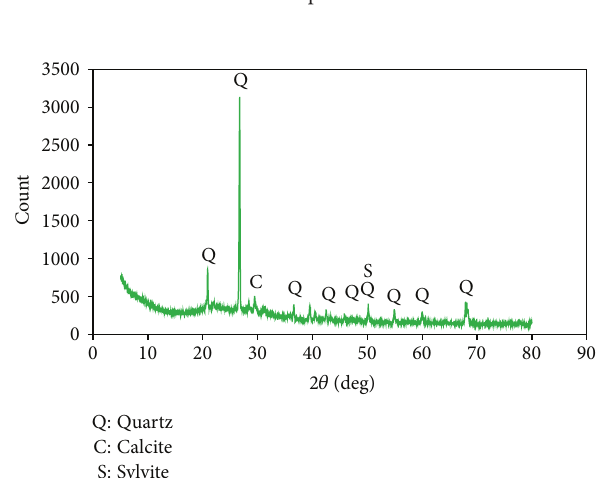
Figure 1: XRD pattern of MK.